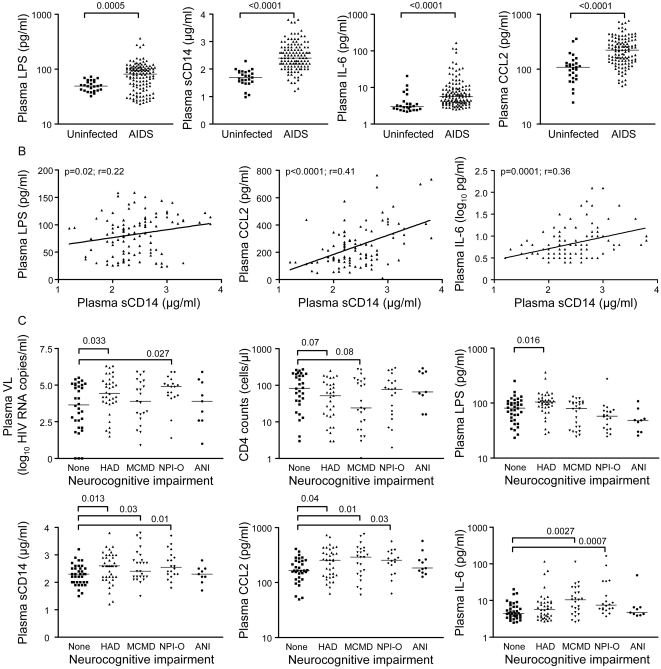
Increased plasma LPS, sCD14, and CCL2 are associated with HAD.(A) Levels of LPS, sCD14, CCL2, and IL-6 were quantified in plasma of AIDS patients (n = 119) and uninfected controls (n = 25). (B) Spearman correlation (r and p-values) was calculated to determine the relationship between the LPS levels and sCD14, and between sCD14 and plasma CCL2 or IL-6. (C) Levels of plasma VL, CD4 counts, LPS, sCD14, CCL2, and IL-6 were compared in AIDS patients classified in 5 groups based on the degree of neurocognitive impairment (NCI) (None, No NCI; HAD, HIV-associated dementia; MCMD, minor cognitive and motor disorder; NPI-O, neuropsychiatric impairment due to conditions other than HIV; and ANI, asymptomatic NCI). Kruskal-Wallis test determined significant differences between the 5 groups in 1C. Median values in 1A and 1C are indicated as horizontal lines and significant differences between the 4 NCI groups versus the no NCI group (None) were determined using the Mann-Whitney test.